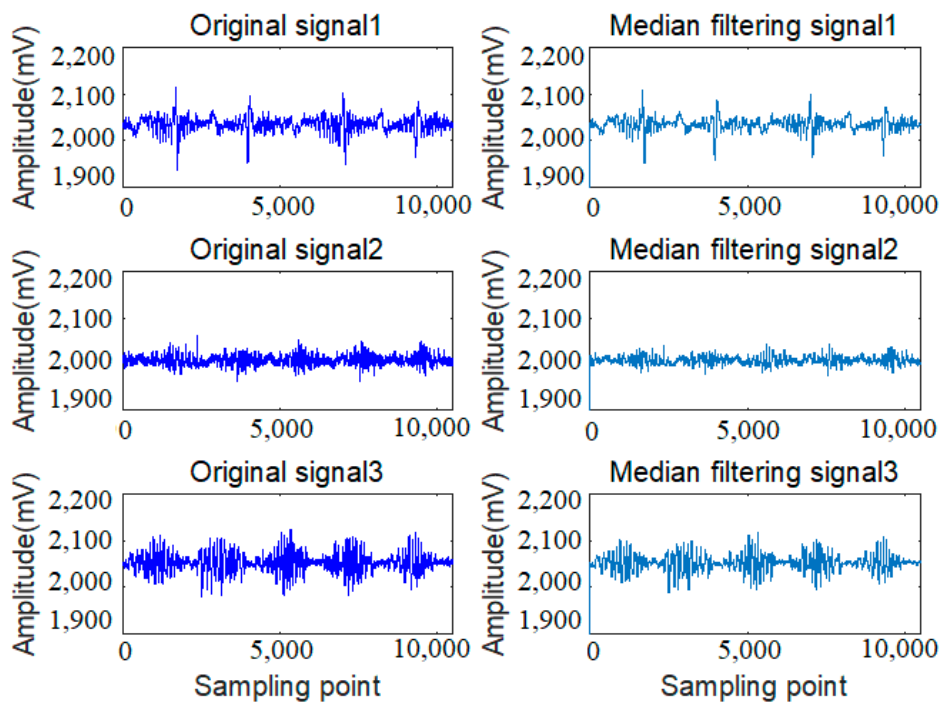
Figure 6. Weak signals processed by median filter. The original weak signals of 1 to 3 correspond with the testing signals of S1 to S3 in Figure 5.